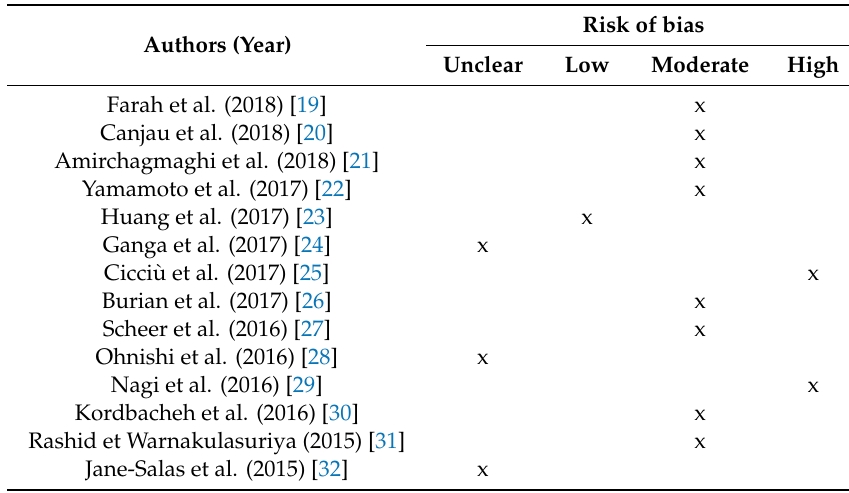
Table 4. Risk of